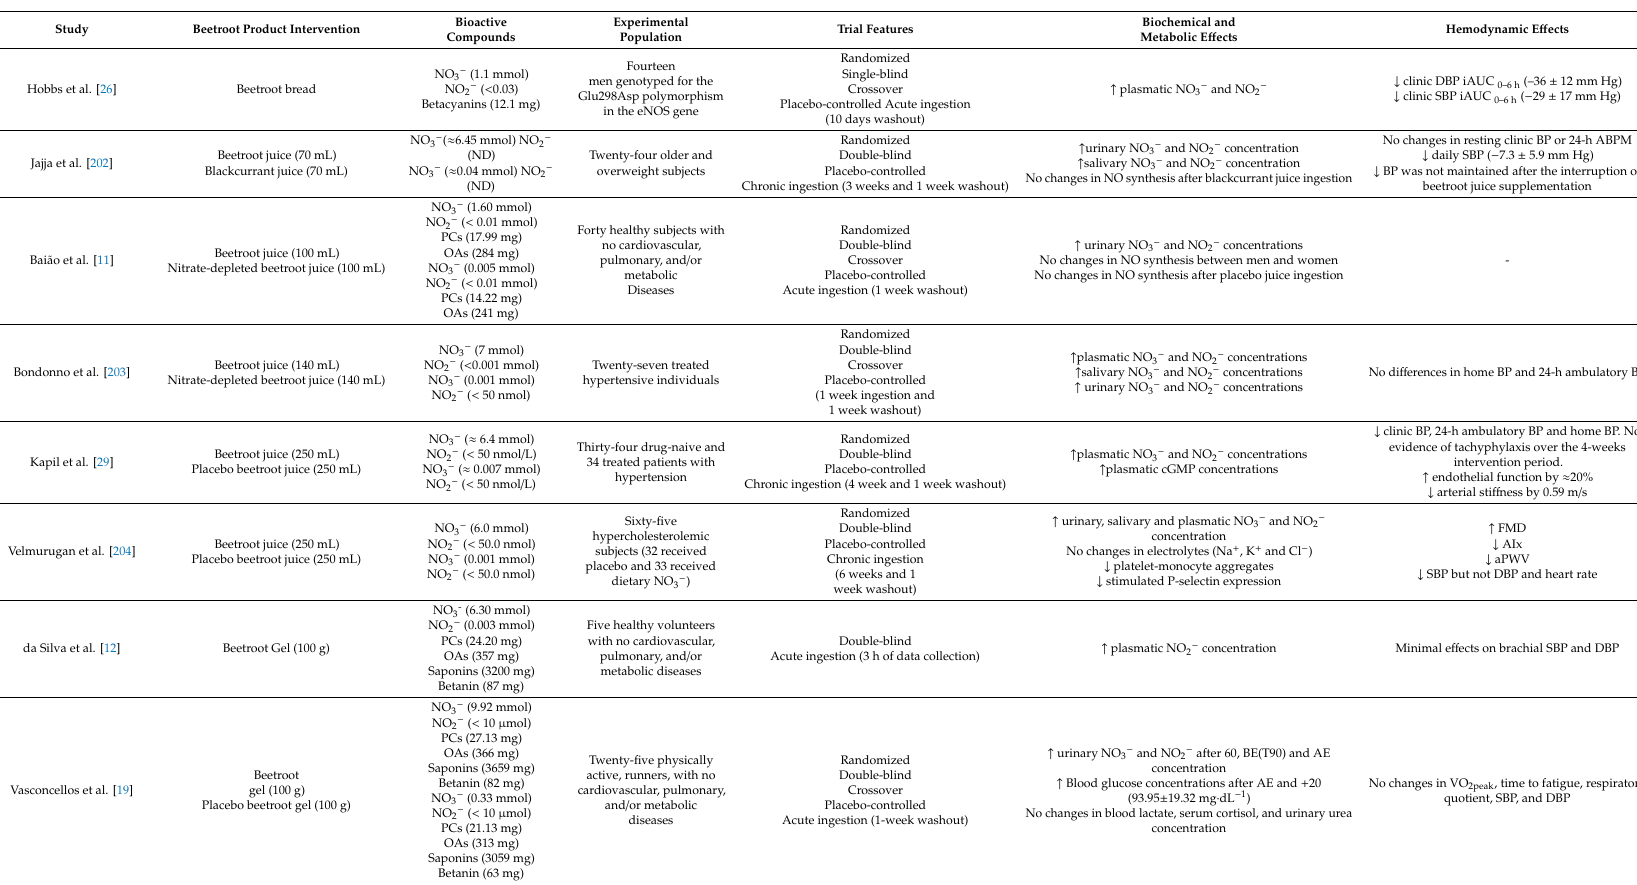
Table 3. Health e ff ects of beetroot supplementation: reports from human intervention trials performed in the last 5 years (2014–2019): Features of beetroot product interventions, supplementation regimen, biochemical and hemodynamic parameters of healthy, physically active or cardiovascular-compromised patients. Study BeetrootProductIntervention Bioactive Compounds Experimental Population TrialFeatures Biochemicaland MetabolicE ff ects HemodynamicE ff ects Hobbsetal.